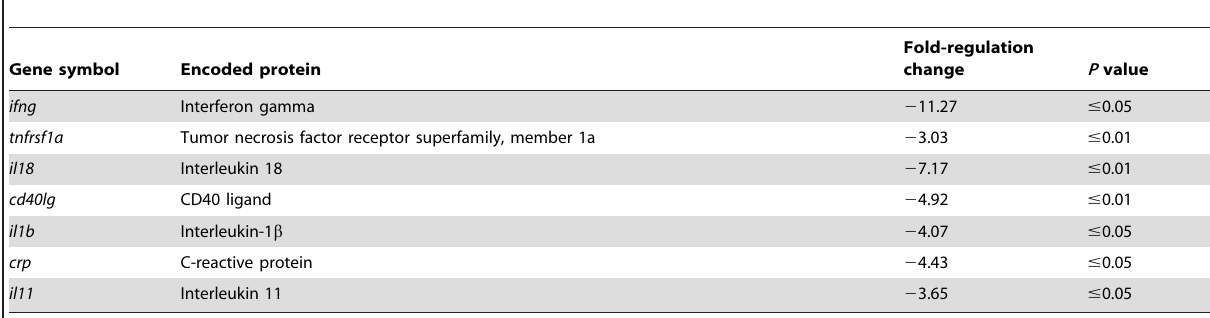
Table 1. SaeR/S-mediated factors elicit host pro-inflammatory transcription during invasive